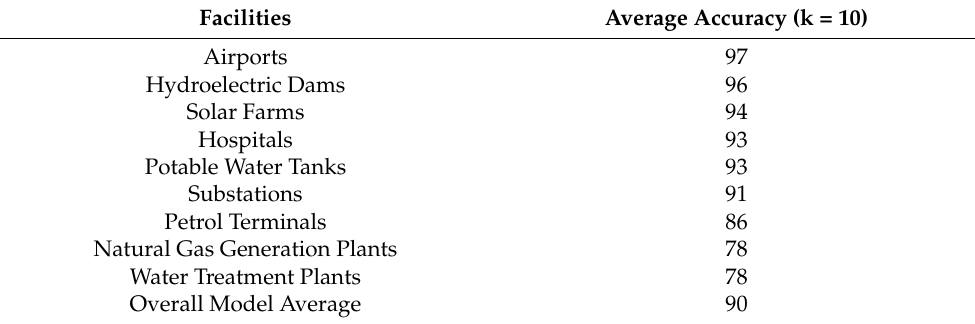
Table 3. Cross-validation average accuracy